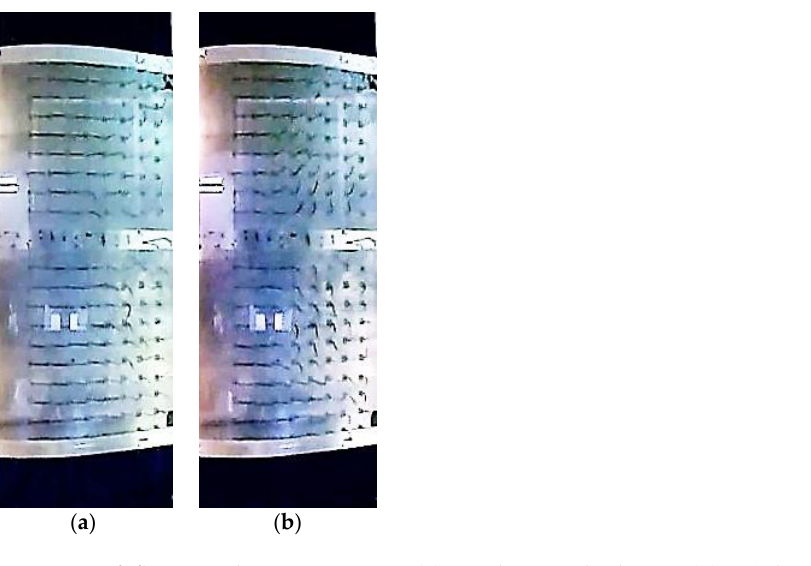
Figure 18. Tuft flow visualization: 15° ± 8°: ( a ) 9.9° downstroke, k = 0.1, ( b ) 9.8° downstroke, k = 0.2.